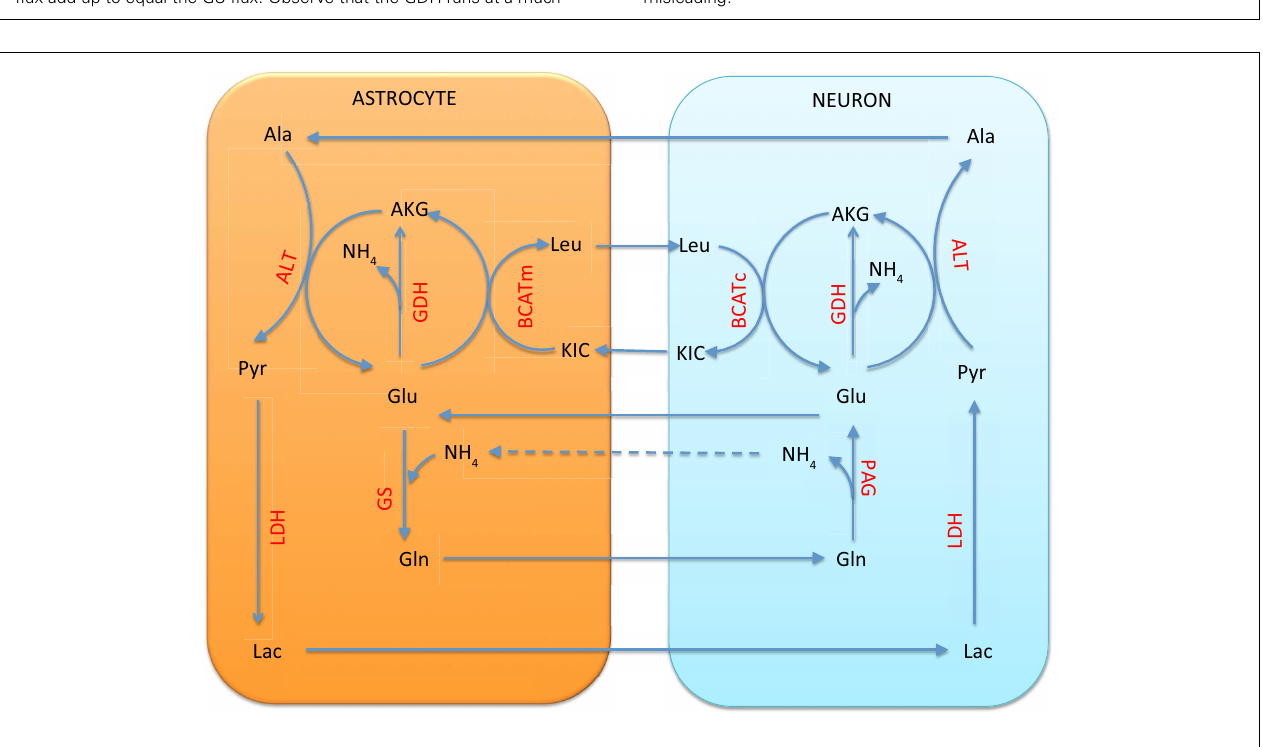
requires no return traffic of ammonia. A stoichiometric equilibrium can be found in which the GDH runs in oxidative direction in all cells, and the combined action of alanine-lactate shuttle and GDH replenishes the NH + in astrocyte. A flux of NH + from neuron to astrocyte is still needed for 4